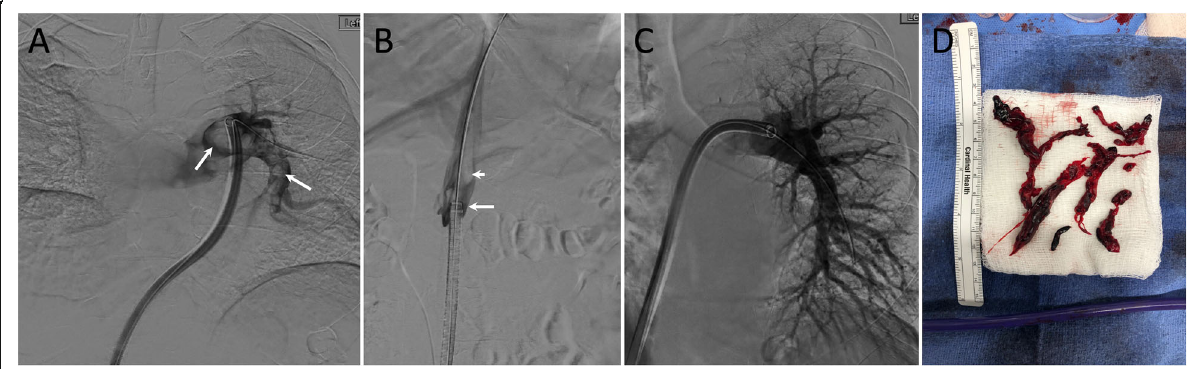
Fig. 2 An example of MT in a patient with a clot at the access site, and why there is a concern for paradoxical embolization if the patient has PFO. a Initial pulmonary angiogram through the Inari catheter (arrows) shows multiple large filling defects in the left pulmonary artery. The catheter crosses the right atrium, tricuspid valve and right ventricle. b Angiogram through a vascular sheath in the right common femoral vein (long white arrow) show large clot (short white arrow) at the tip of the Inari catheter. There is a risk of paradoxical embolization if patient has PFO in case of release of clot from the tip of catheter during catheter pull back. c Final angiogram shows almost complete removal of the clots. d A sample of thrombus was removed during mechanical